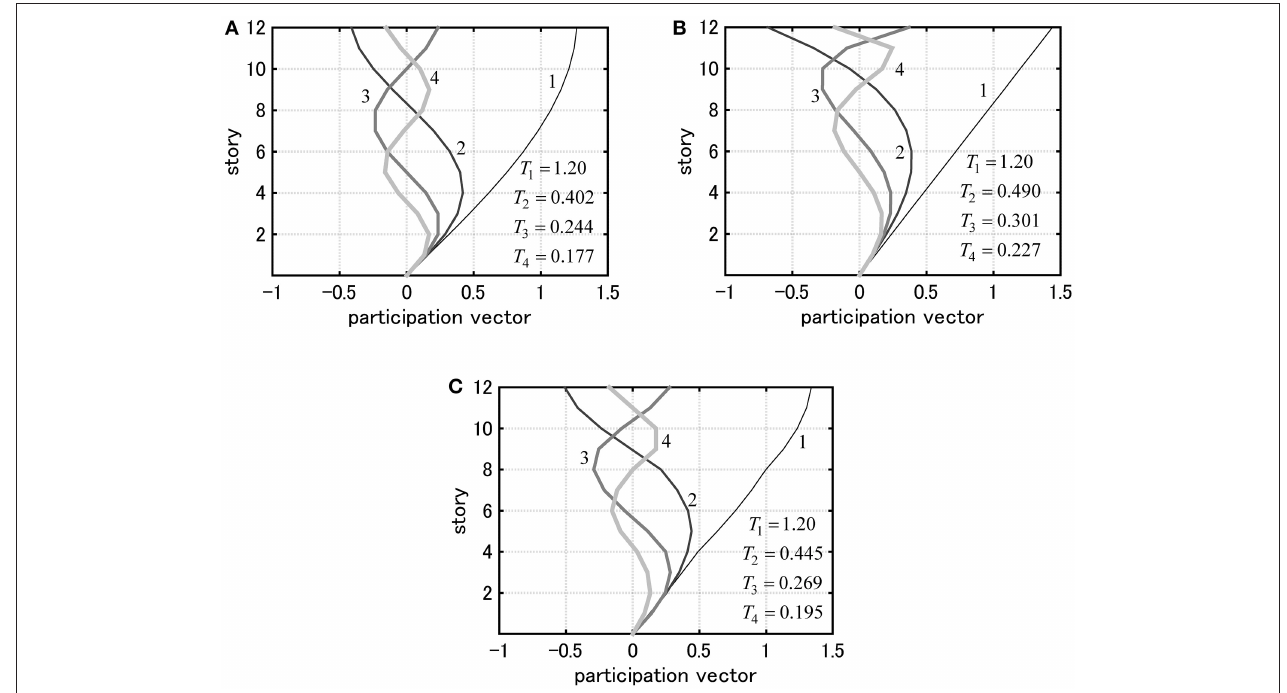
FIGURE 4 | Eigenmodes multiplied by participation factors (participation vectors) and natural periods for three models: (A) Model 1, (B) Model 2, (C) Model 3.